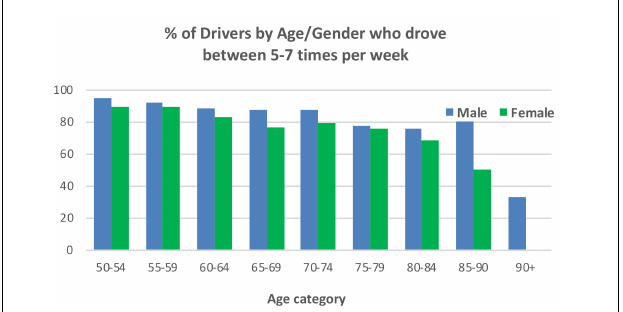
FIGURE 3 | Percentage of Drivers across Age and Gender who drove between 5 and 7 times per week.